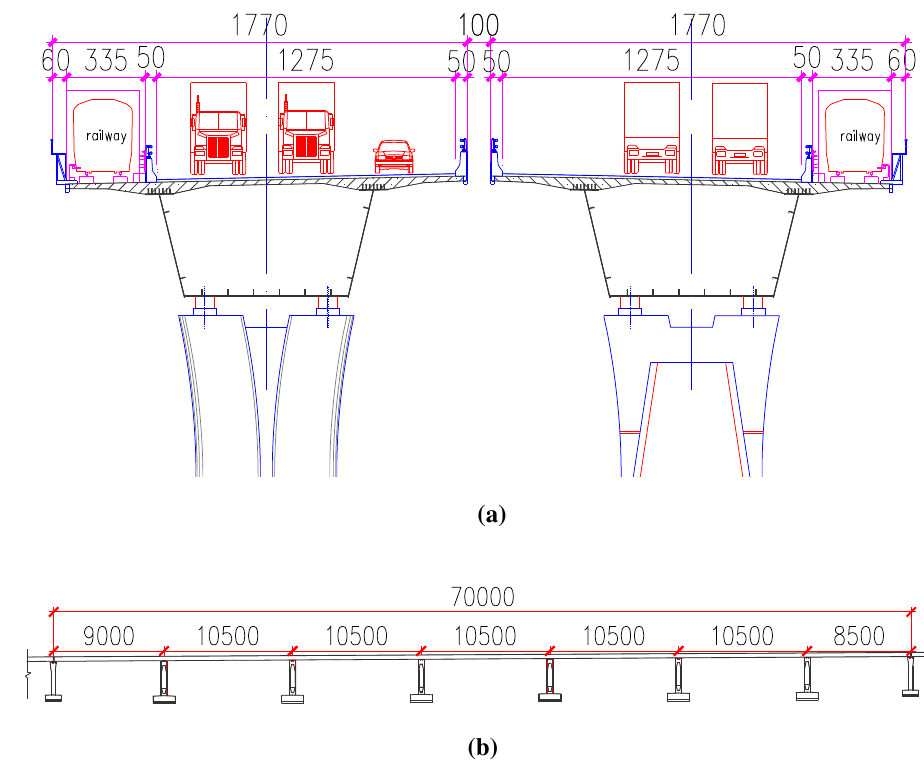
Fig. 1 Configuration of the continuous box girder bridge over Shanghai Yangtze River and the transportation layout (unit: cm): a cross section and b